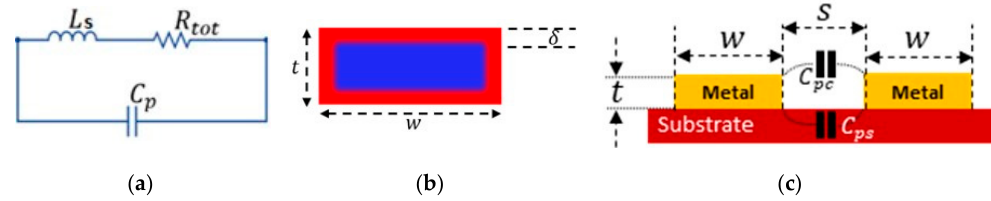
Figure 3. Parasitic effects: ( a ) Lumped model of the spiral inductor showing the inductor ( 𝐿 (cid:3046) ), parasitic resistance and capacitance ; ( b ) Skin effect on a rectangular conductor, with current flowing only in the red area; ( c ) The parasitic capacitance is due to the air gap between coil turns (cid:3435)𝐶 (cid:3043)(cid:3030) (cid:3439) and the substrate material (𝐶 (cid:3043)(cid:3046) ) .